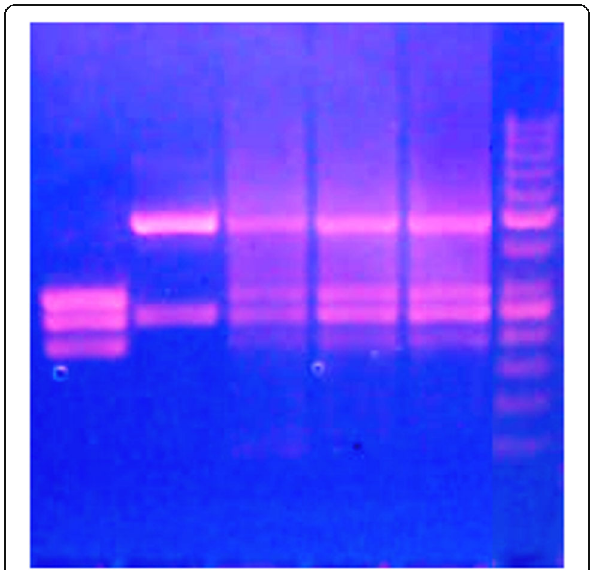
Fig. 2 Vitamin D receptor gene polymorphism (Taq 1). Lane 1: homozygous mutant CC genotype (290bp, 245bp and 205 bp). Lane 2: homozygous wild TT genotype (495 bp and 245bp). Lanes 3,4 and 5: heterozygous genotype TC (495bp, 290bp, 245bp and 205 bp). Lane 8: 50 bp DNA Ladder (50,100,150,200,250,300,400,500, 600,700, 800, 900, 1000